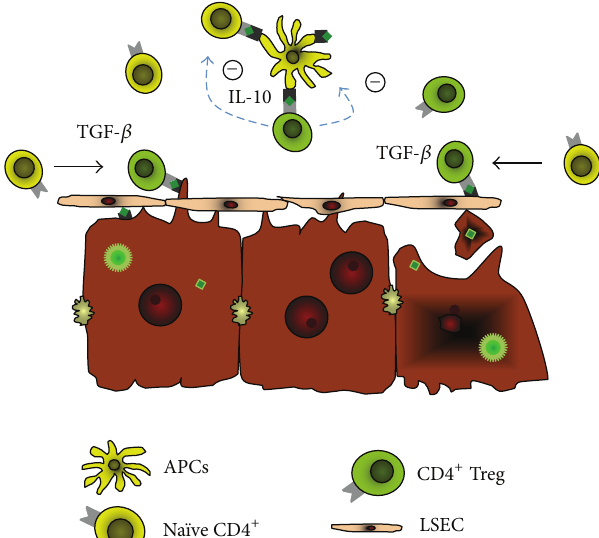
Figure 2: Role of CD4 + Tregs in chronic viral hepatitis. Based on data from chronically HCV-infected patients and experimental models, we propose the following role for CD4 + Tregs in chronic viral hepatitis. When liver cells are exposed to viral particles within the context of minimal innate immune responses and inflammatory signals, antigen presentation of virus-derived peptides by hepatocytes could occur with minimal costimulation and within the tolerogenic environment of the hepatic sinusoid (IL-10 and TGF- 𝛽 ) leading to the conversion of virus-specific na¨ıve CD4 + T cells into Tregs (left). Antigen presentation by liver sinusoidal endothelial cells (LSEC) could also occur through the release of viral antigens by hepatocyte turnover leading to the conversion of virus-specific na¨ıve CD4 + T cells into CD4 + Tregs. These virus-specificCD4 + Tregs could then inhibit the activation of virus-specific effector T cells and efficient antigen presentation by APCs through IL-10